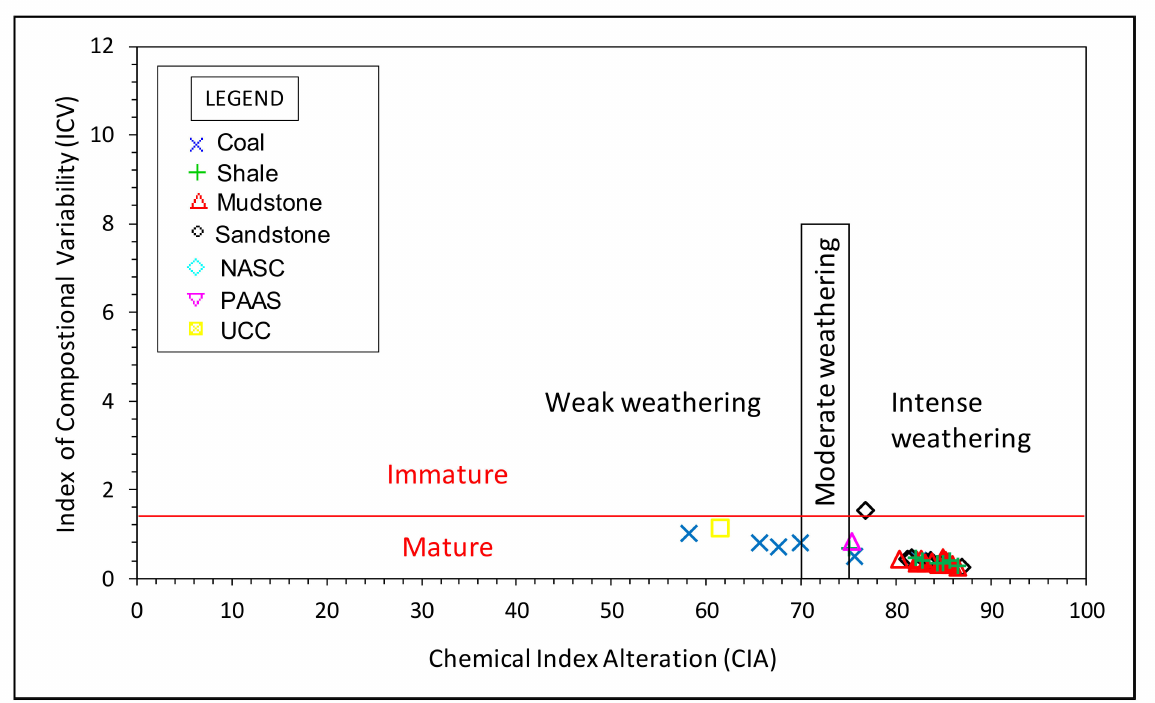
Figure 15. Binary plot of CIA against ICV for the Madzaringwe Formation samples (Background field after [37]).